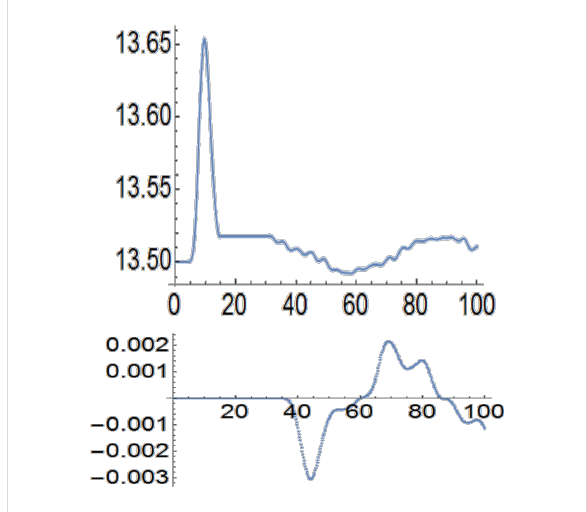
Figure 3: Upper panel: up-spin population of the left storage cube versus time measured in units of τ . Lower panel: spin-up current in the wire connecting the two 27-site cubes, where the hopping integral is t ext = 0.25 t h .